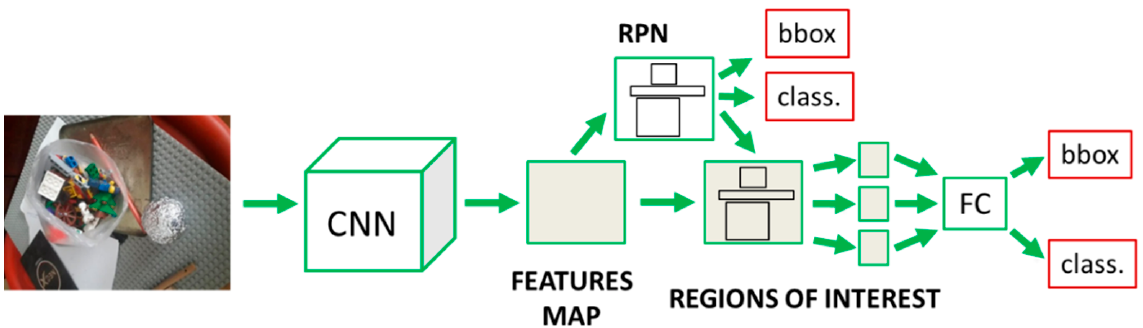
Figure 3. Faster R-CNN architecture.